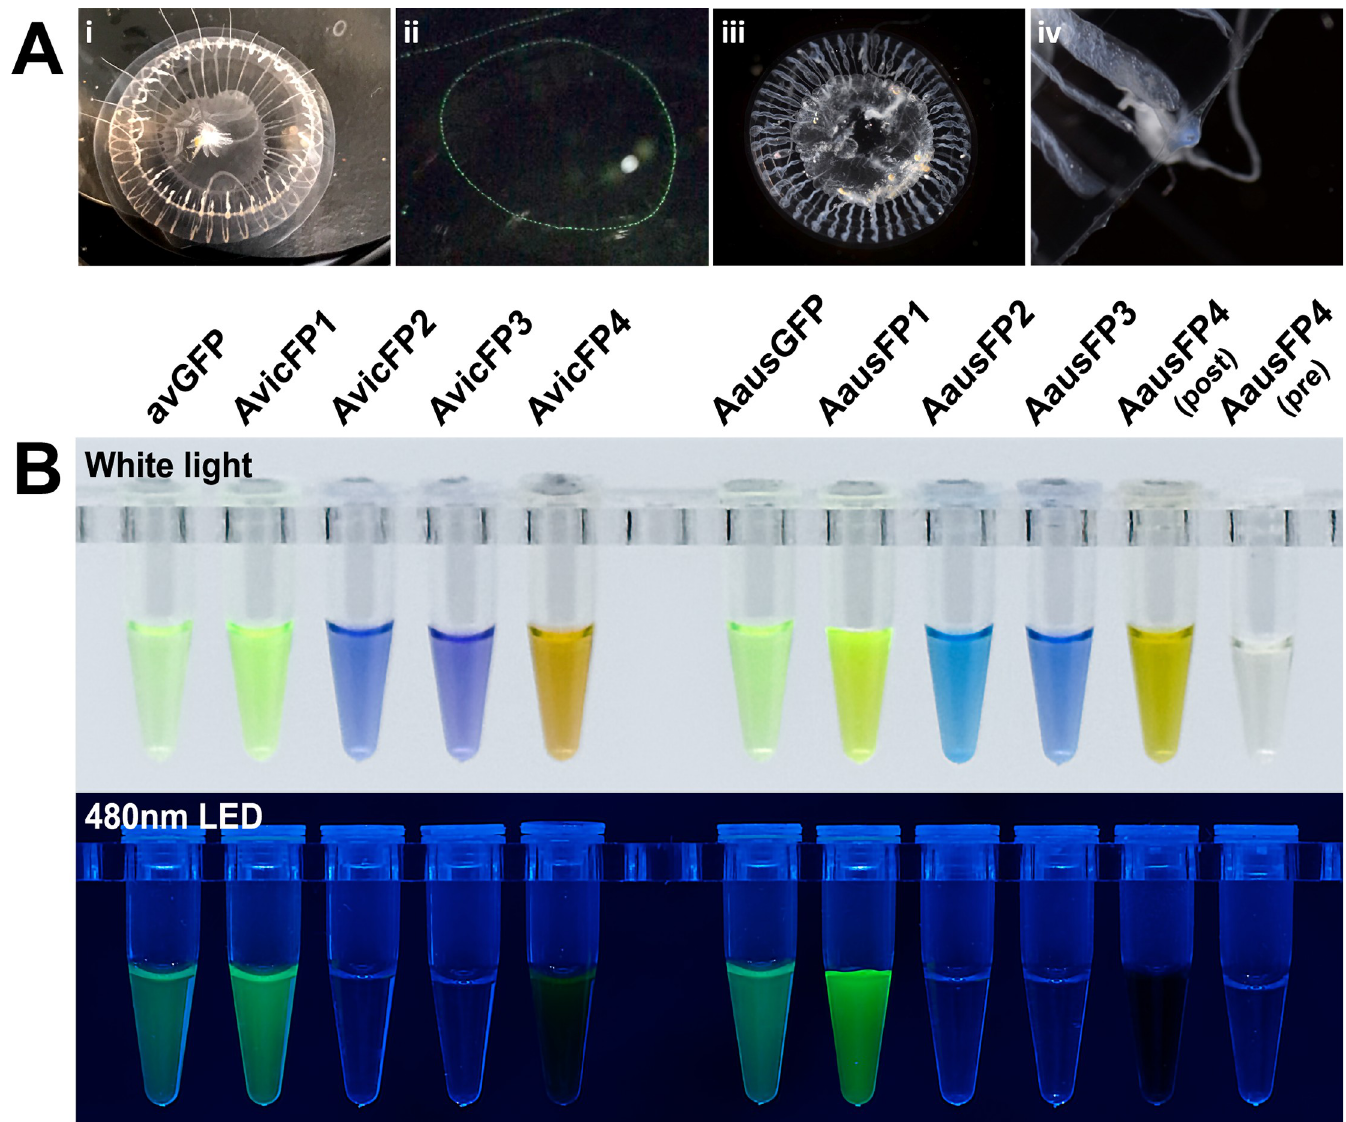
Fig 1. Photographs of Aequorea individuals from this study and purified fluorescent proteins cloned from these samples. (A) White-light (i) and fluorescence (400-nm LED illumination) (ii) photographs of A . victoria and white-light photographs of A . cf. australis (iii, iv). The blue coloration of A . cf. australis is shown in the higher magnification image of one of its tentacle bulbs (iv). (B) Purified recombinant proteins from Aequorea species, shown under white light and 480-nm LED without emission filters. Protein concentrations were adjusted to display similar optical density as judged by eye and were between 0.5 and 2 mg/ml for all samples.